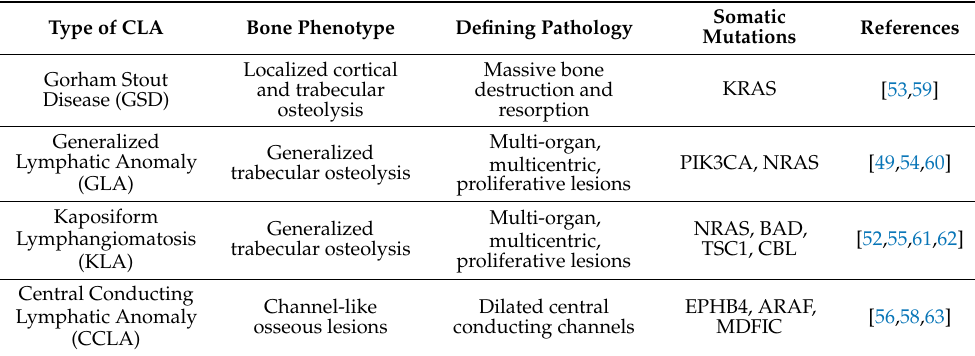
Table 1. Genetic mutations associated with Complex Lymphatic Anomalies. Each CLA has been identified with at least one somatic mutation. Type of CLA Bone Phenotype Defining